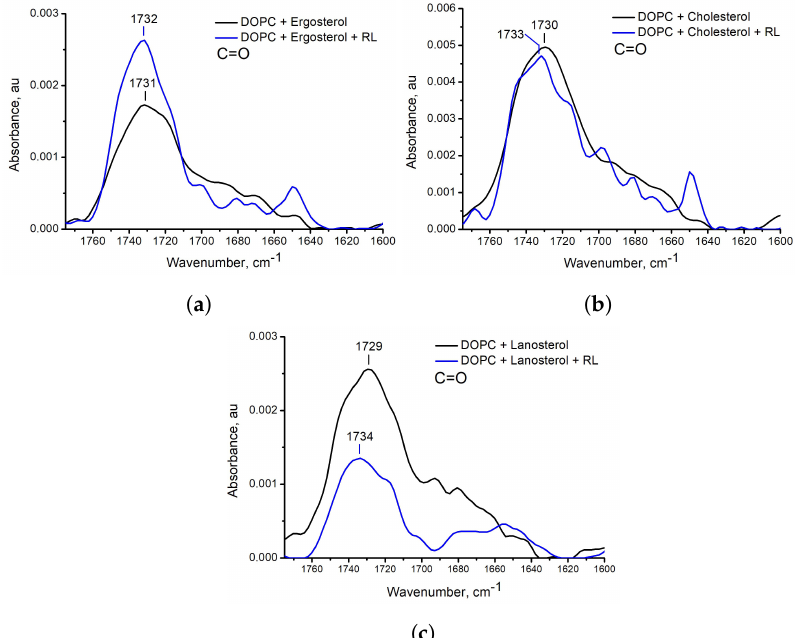
Figure 8. ATR − FTIR spectra in the region of C=O vibration for DOPC liposomes with ergosterol ( a ), cholesterol ( b ), and lanosterol ( c ) without rhamnolipids (black solid line) and with aqueous injection of rhamnolipids (blue solid line).